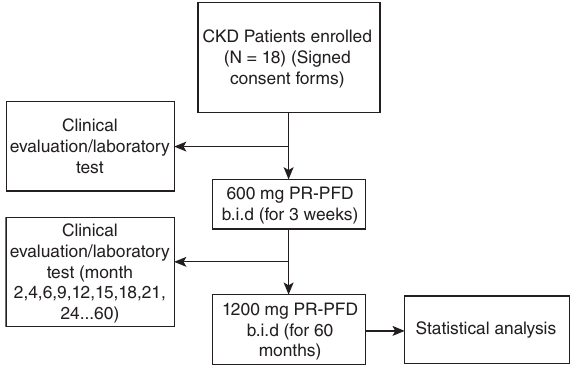
Figure 1. Study flowchart. Eighteen CKD patients were enrolled, 14 patients completed the 60-month treatment with prolonged-release